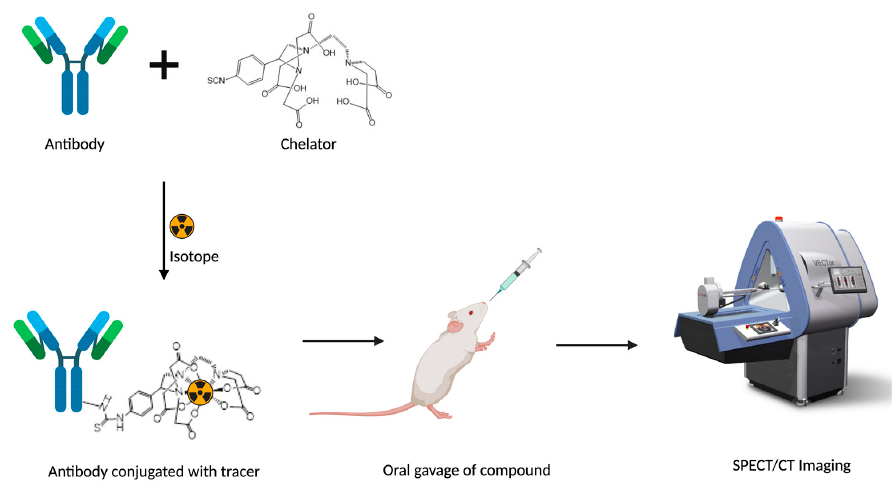
Figure 4. Conjugation of the drug molecule, e.g., an antibody, to a radioisotope using a chelator followed by oral gavage of the radiopharmaceuticals and biodistribution study in mice using SPECT/CT imaging in a preclinical scanner.